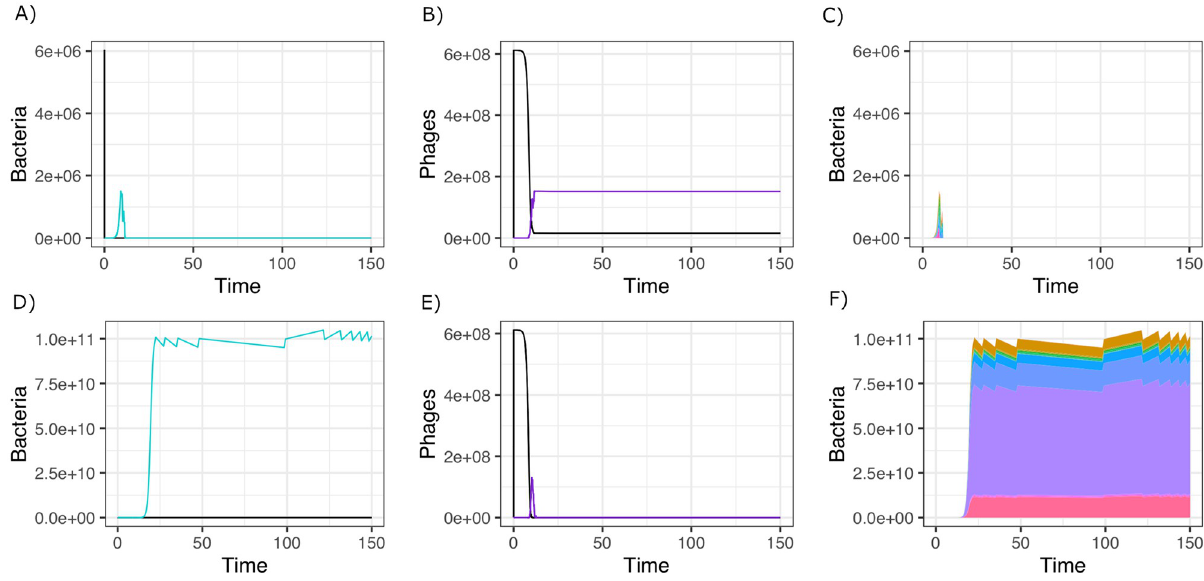
Fig 2. Example of time courses the model produces when 6 � 10 6 S bacteria are infected by 10 5 WT phages ( α = 5.12 � 10 − 6 , μ = 10 − 6 , b WT = 100, b m = 70, g = 1.3). Panels A, B and C show the results of a single simulation where the phage drives the bacteria to extinction. Panels D, E and F show the results of a single simulation where the phage is driven to extinction by the CRISPR-Cas system. Panels A and D show the number of bacteria that are sensitive (black) and resistant (blue). Panels B and E show the number of phages that are WT (black) and escape mutants (purple). Panels C and F show the strains diversity of the bacterial population through time, each colour representing a strain.